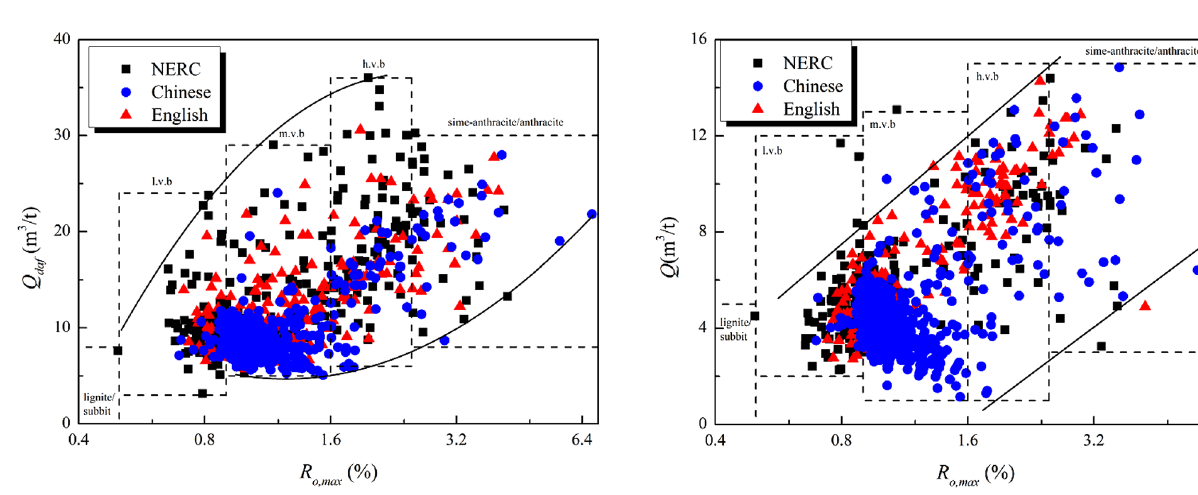
Fig. 3 Value of adsorption constant Q daf versus vitrinite reflectance R o ; max . (Data size: NERC-290, Chinese (Yu et al. 2005; Zhang 2007; Zheng 2012; Zou et al. 2013; Liu et al. 2015; Yue et al. 2016)-217, English(Joubert et al. 1973; Yalc¸in and Durucan 1991; DeGance et al.